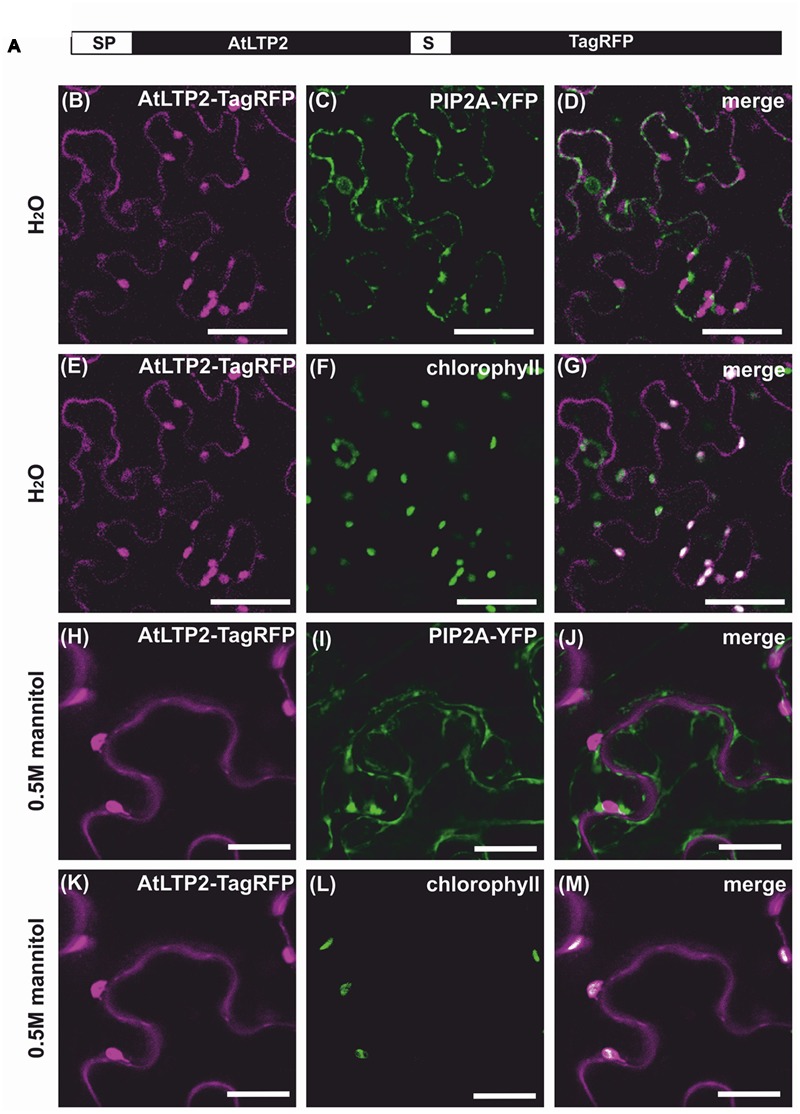
AtLTP2-TagRFP is dually targeted to the cell wall and the plastids. The fusion protein AtLTP2-TagRFP displayed in (A) was produced together with the plasma membrane (PM) marker PIP2A-YFP in Nicotiana benthamiana leaves. Detached leaves were observed under hypotonic (B–G) or hypertonic (H–M) conditions. The Tag-RFP fluorescence signal is false-colored in magenta in the left column. The PM and the plastid markers (chlorophyll auto-fluorescence) are false-colored in green in the second column and the merge is presented in white in the right column. Note that under plasmolysis, the AtLTP2-TagRFP fluorescence in the cell wall is excluded from the PM fluorescence of PIP2A-YFP and that the additional co-localization of AtLTP2-TagRFP fluorescence with the chlorophyll auto-fluorescence indicates its plastid localization. Scale bars: 50 μm.